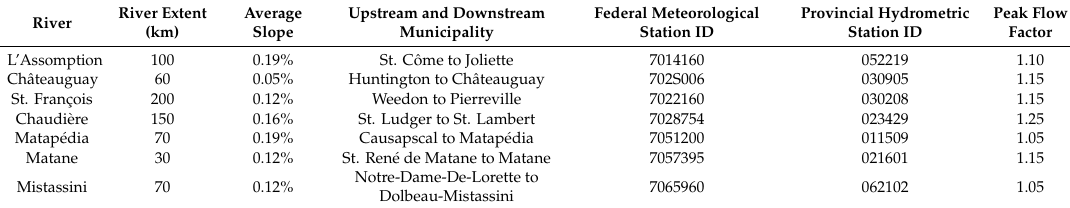
Figure 1. Location, watershed area and dominant flow direction of the seven rivers included in the study. Table 1. List of the seven rivers with their respective studied extent, average slope, reference meteorological and hydrometric stations as well as average peak flow factor.